Question: Identify the chart type used in this figure.
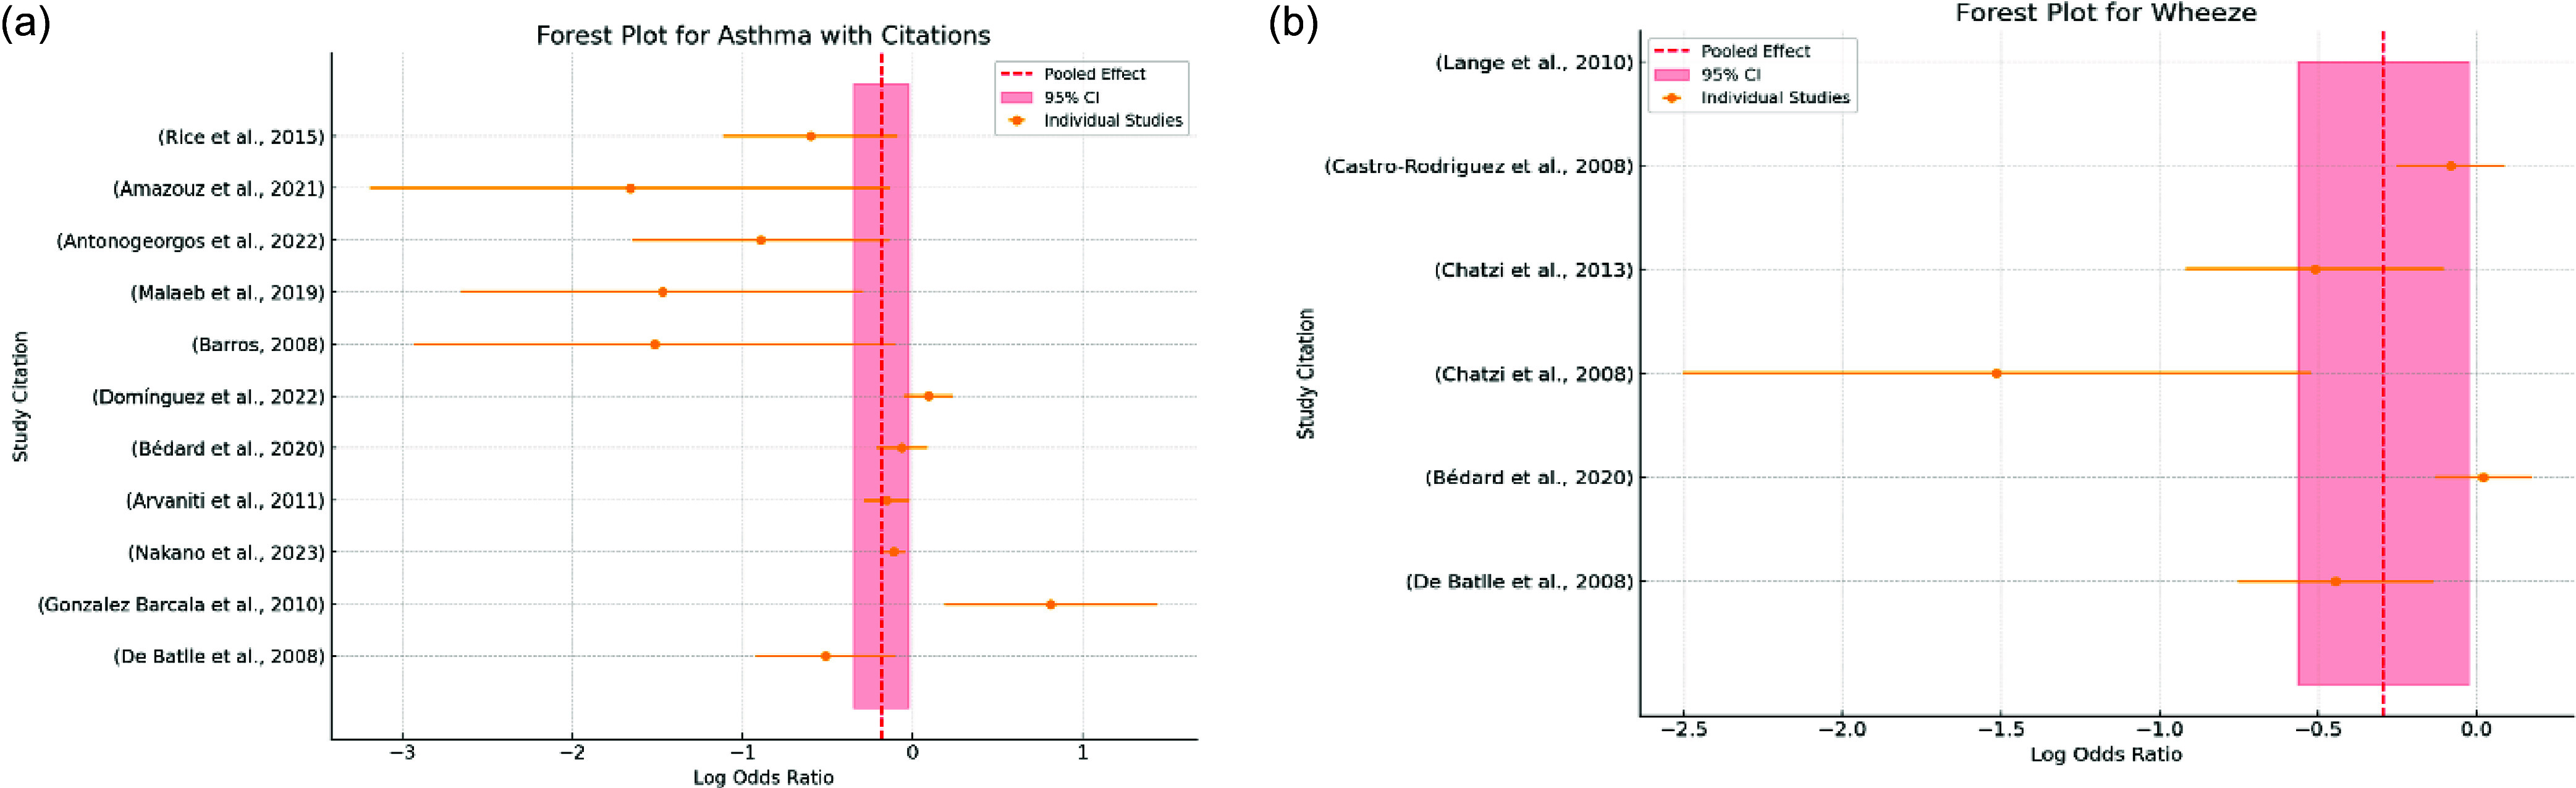
Answer: forest